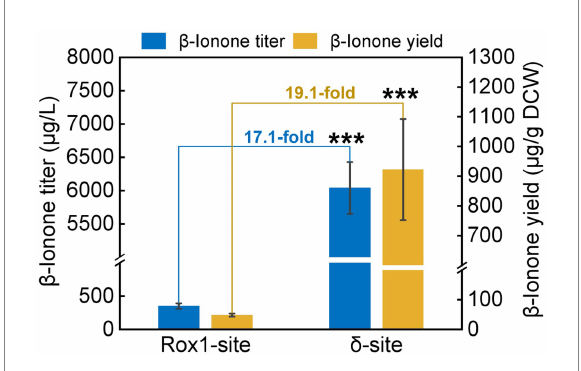
FIGURE 4 The production of β -ionone by the strains A10-rox1-NtCCD1-3 (Rox1-site) and 9# A10- δ -NtCCD1-3 ( δ -site). Error bars represent the standard deviation of three biological replicates. p values were determined by one-way ANOVA (*** p <